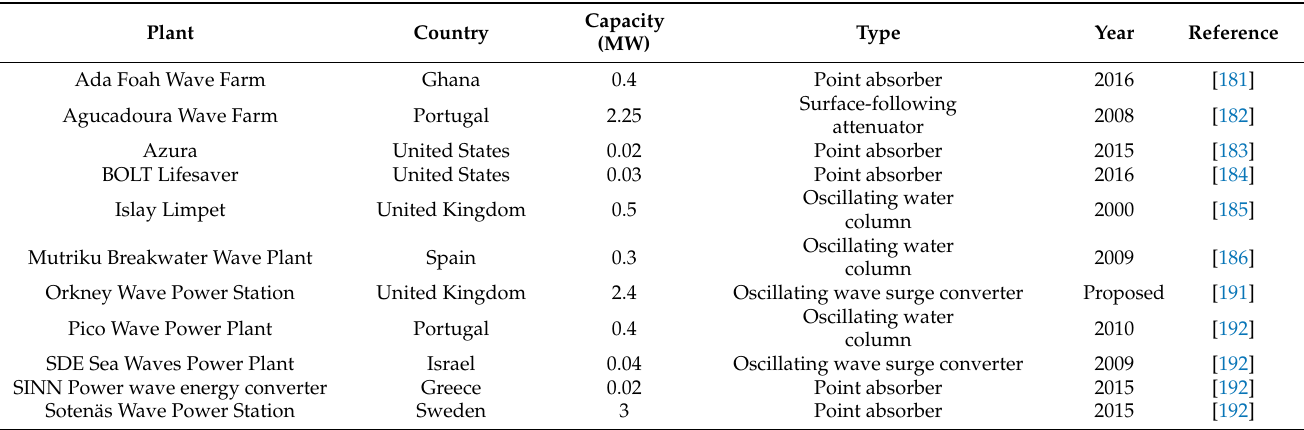
Table 8. Power stations that run on wave